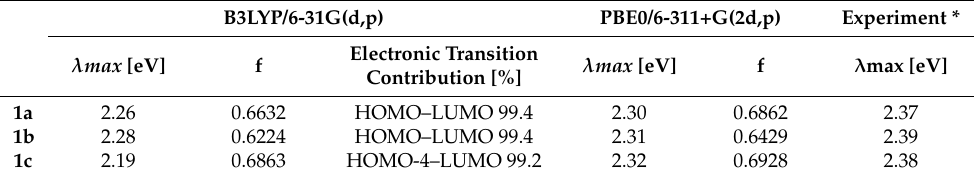
Table 2. Theoretically calculated absorption maxima (in eV), values of oscillator strength (f), and molecular orbital contributions to electronic transition in methanol for 1a–c compared with experi- mental absorption